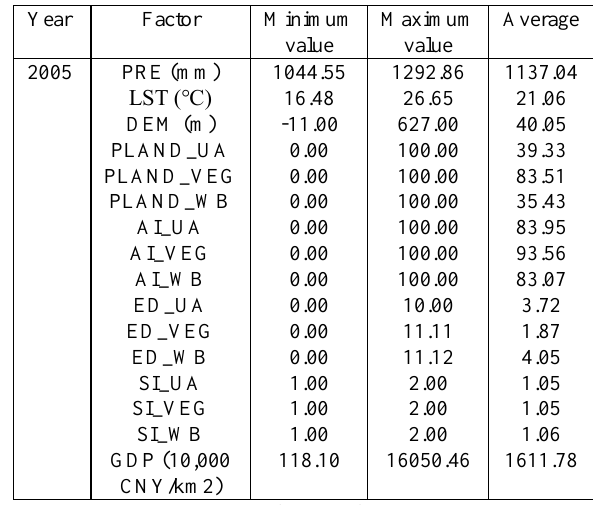
Table 5. Details of impact factors in 2005.